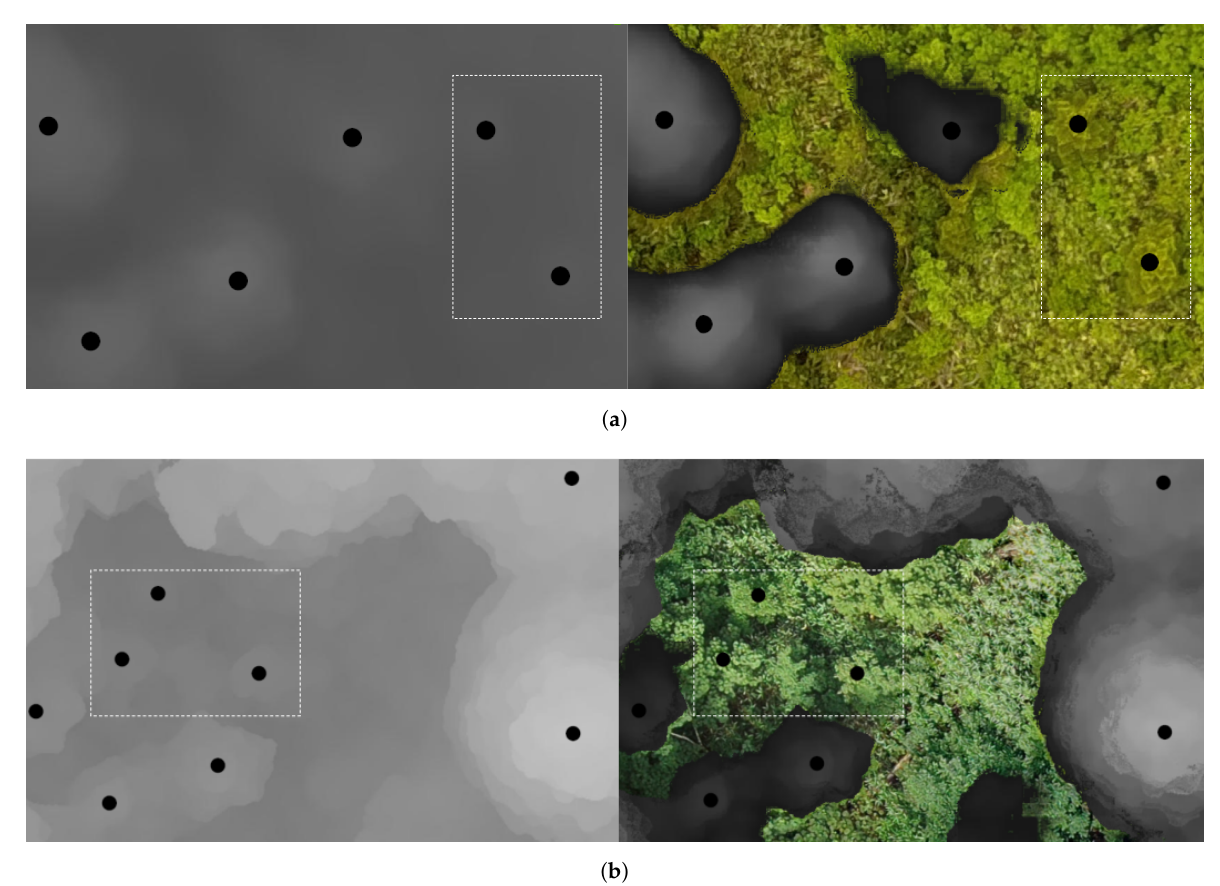
Figure 6. ( a , b ) annotated treetops on small trees that were in DSM (left) but do not appear on the nDSM (right). The floor regions in the nDSM have been left transparent so the part of the orthomosaic considered as “floor” is clearly visible. The treetops missed are, thus, those painted over RGB (not grayscale) areas. Table 2. Tree crown detection method performance. Results of the matching percentage (m%) and counting measure (cnt) are presented for each nDSM and the total average. Positive values for the cnt criterion indicate underestimation of the number of trees present while negative values indicate overestimation. For this criterion the average of absolute values was computed. This table show the result using our data with previously reported